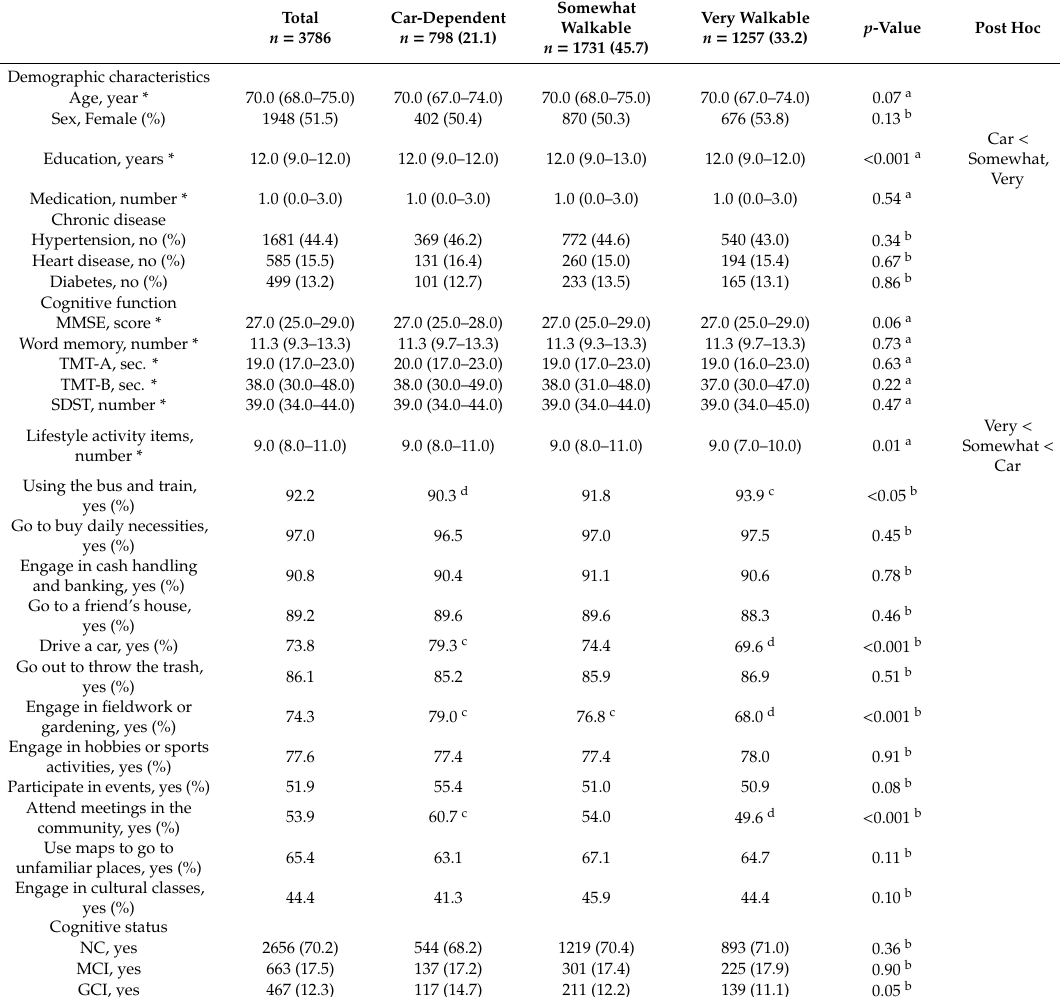
Table 1. Demographic characteristics of older adults from each neighborhood amenities